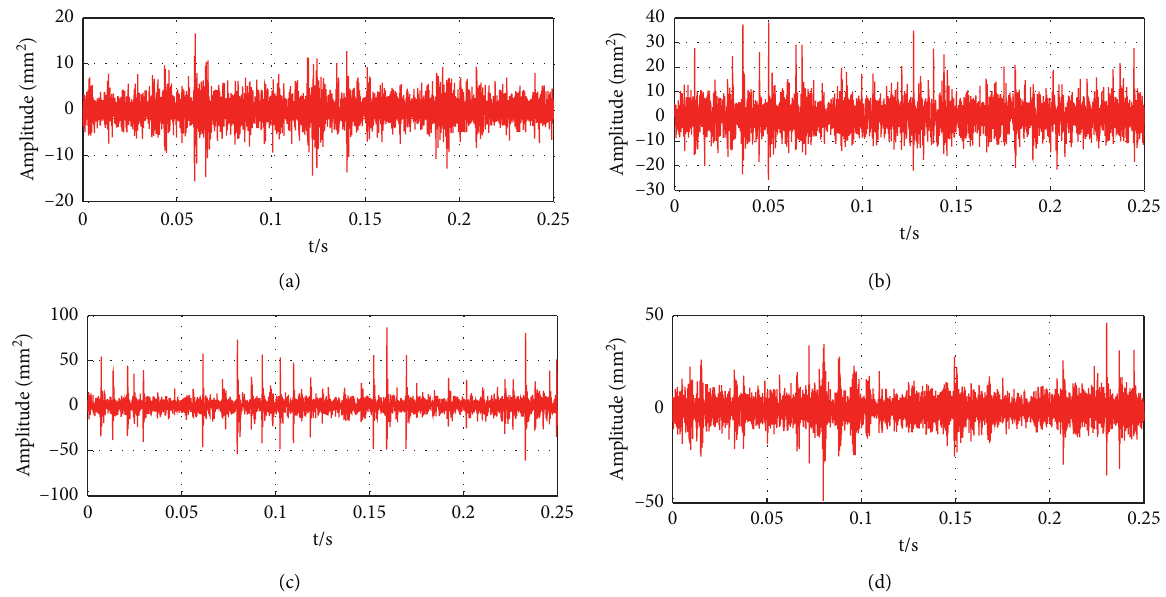
Figure 5: The collected vibration signal. (a) Normal status. (b) 1/3 broken tooth. (c) 2/3 broken tooth. (d) Severe scratches. Table 1: The MPE and S k of the reconstructing signal. The scale factor f